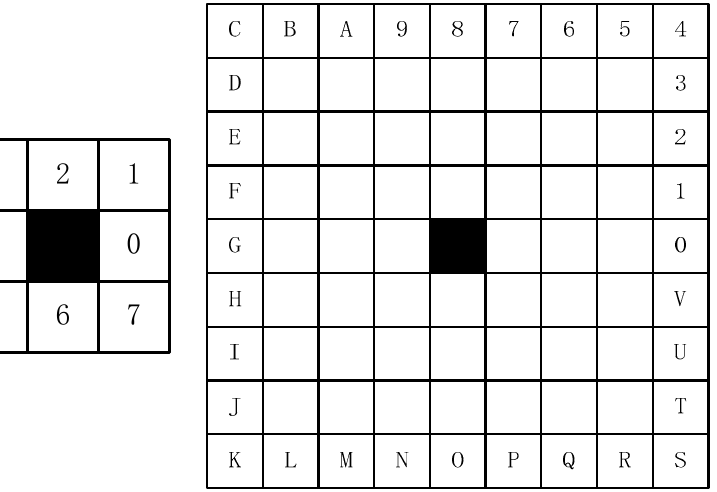
Figure 10. The directions of chain code ( left ) and enhanced angle chain code ( right ).